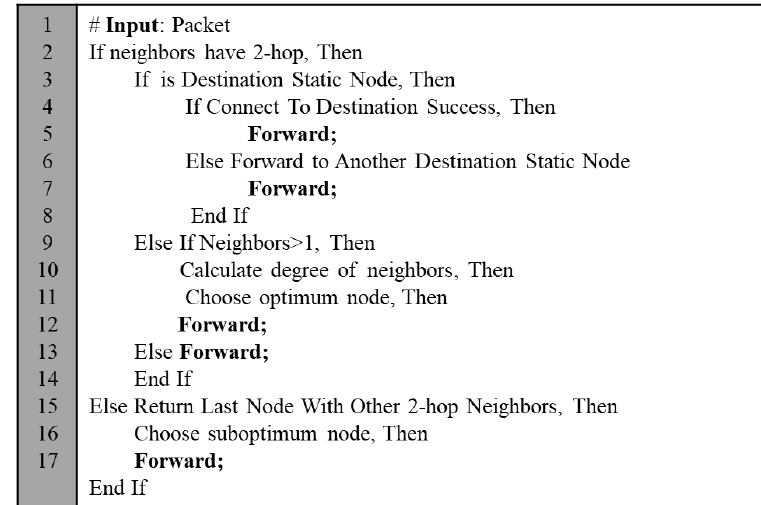
Figure 3. Evaluation framework of the intersection decision.